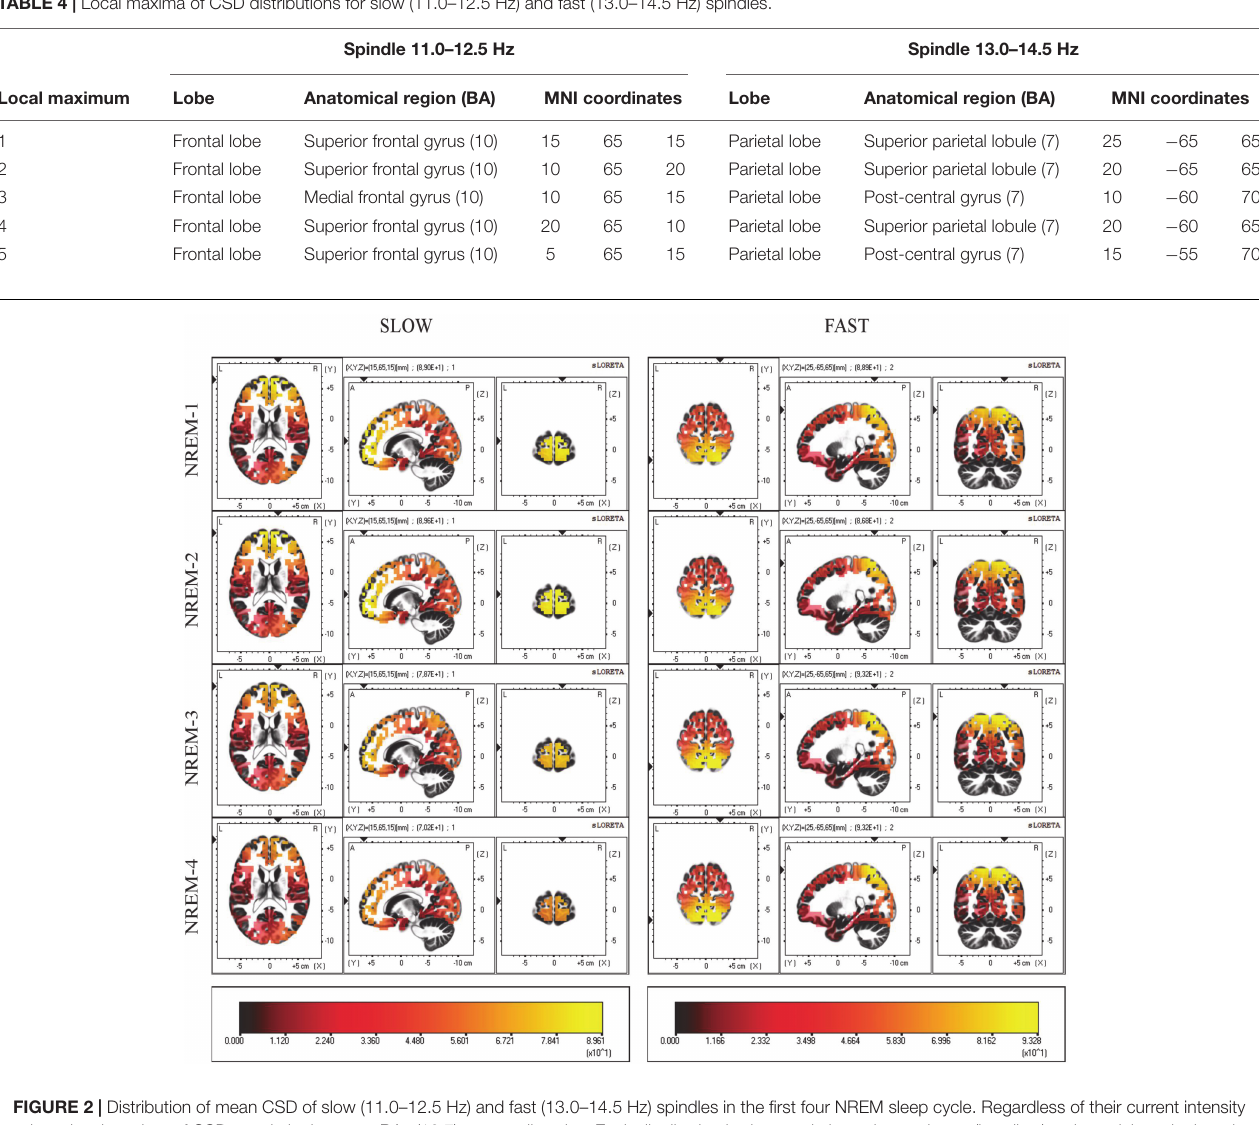
TABLE 4 | Local maxima of CSD distributions for slow (11.0–12.5 Hz) and fast (13.0–14.5 Hz) spindles.